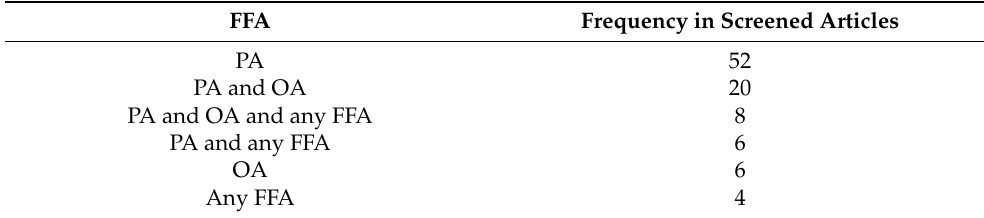
Table 2. Frequency of FFA and FFA combinations used in screened literature ( n = 96). Free fatty acids (FFA). Palmitic acid (PA). Oleic acid (OA). Any FFA is referring to myristic, stearic, palmitoleic, linoleic, linolenic, methylpalmitic, docosahexaenoic, and arachidonic acid. FFA